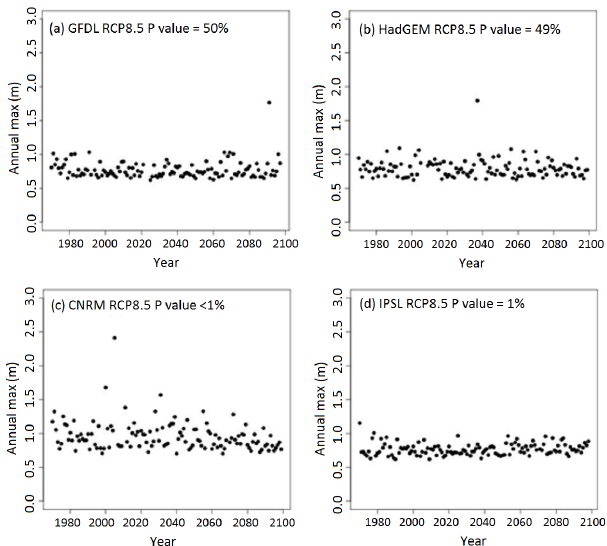
Figure 9. Simulated annual maxima of significant wave height (me- tres) obtained from the (a) GFDL, (b) HadGEM, (c) CNRM and (d) IPSL-forced simulations. The P value indicates the statistical significance of the improvement in fit when using a non-stationary GEV model: a large P value indicates little improvement; a small P value indicates significant